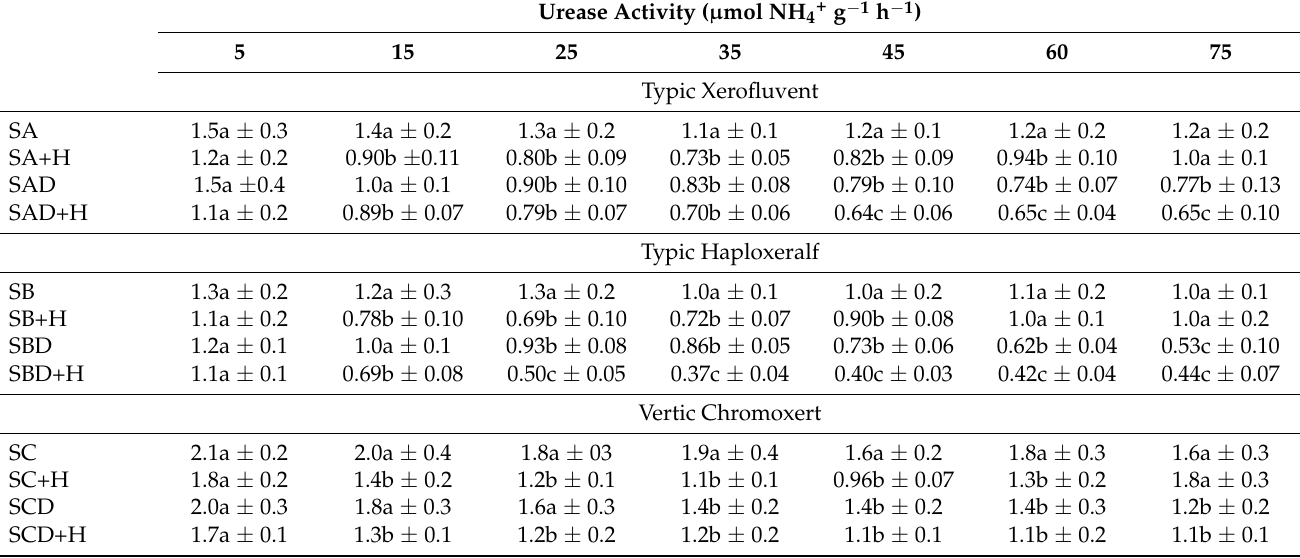
Table 3. Evolution of urease activity (mean ± standard error, n = 3) in watered and non-watered soils with MCPA during the